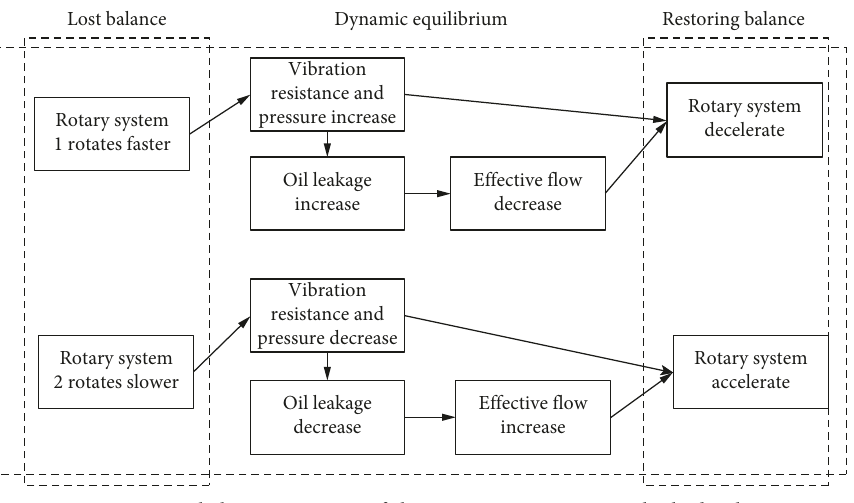
Figure 2: Dynamic balancing process of the two rotary systems in the hydraulic